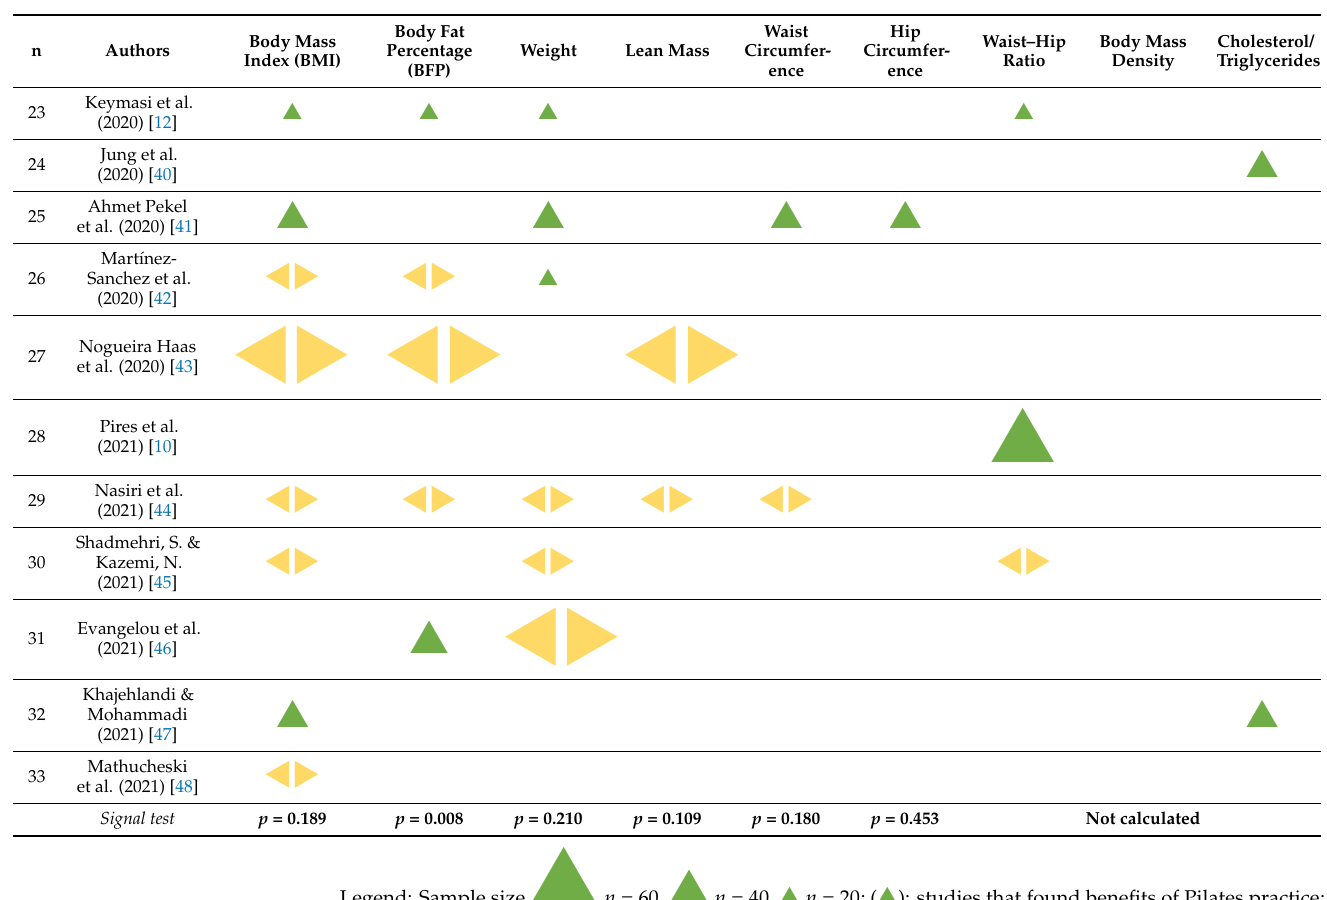
Table 2. Effect direction plot and signal test.